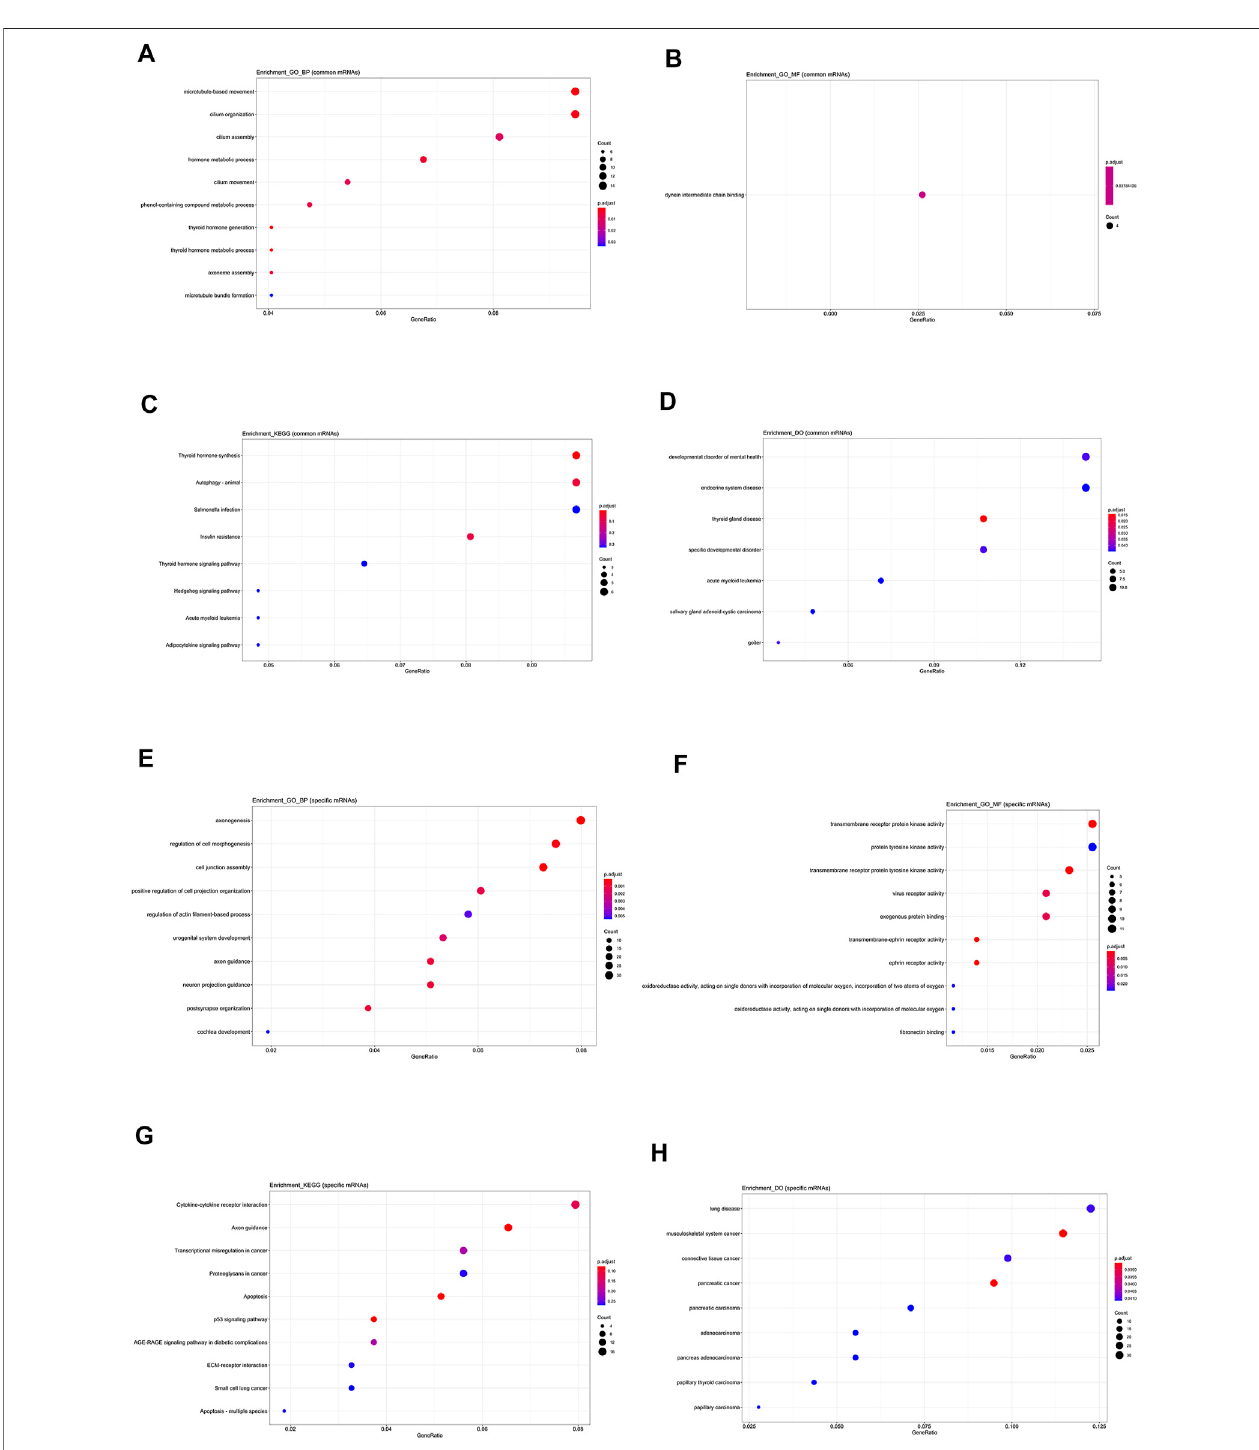
FIGURE 5 | Functional analysis on common and speci fi c mRNAs in lncRNA-mRNA co-expression network. (A) The biological process items of common mRNAs by GO analysis. (B) The molecular function items of common mRNAs by GO analysis. (C) Functional enrichment analysis by KEGG for common mRNAs. (D) Functional enrichmentanalysisbyDOforcommonmRNAs. (E) Thebiologicalprocessitemsofspeci fi cmRNAsbyGOanalysis. (F) Themolecularfunctionitemsofspeci fi cmRNAs by GO analysis. (G) Functional enrichment analysis of KEGG for speci fi c mRNAs. (H) Functional enrichment analysis of DO of speci fi c mRNAs.